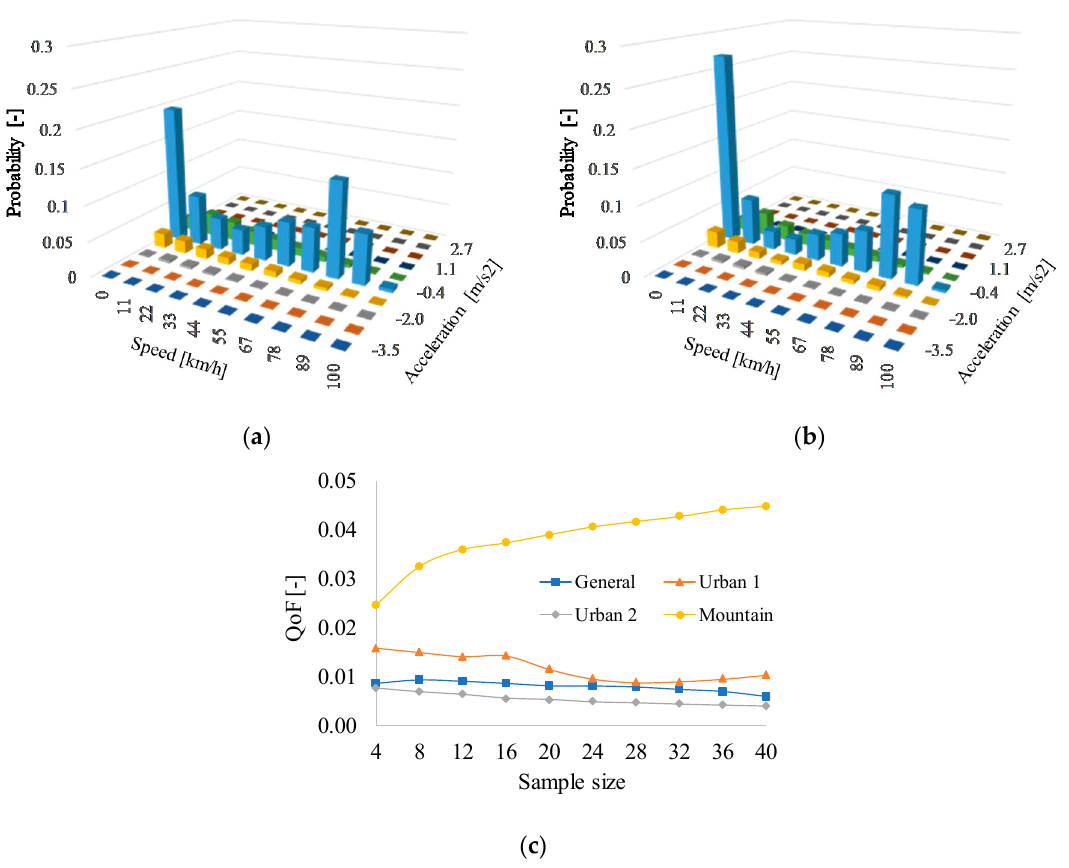
Figure 3. Comparison of the speed-acceleration probability distribution (SAPD) obtained for: ( a ) The sampled trips and; ( b ) The SFC closest to the average measured SFC of the sampled trips; ( c ) QoF as a function of the number of sampled trips.